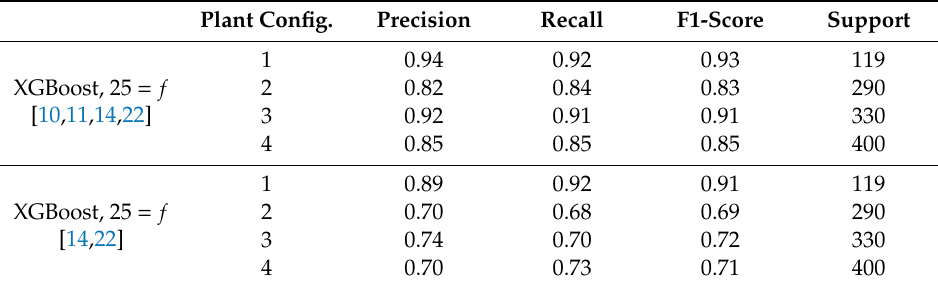
Table 10. Validation—selected biometric data for plant configuration identification.